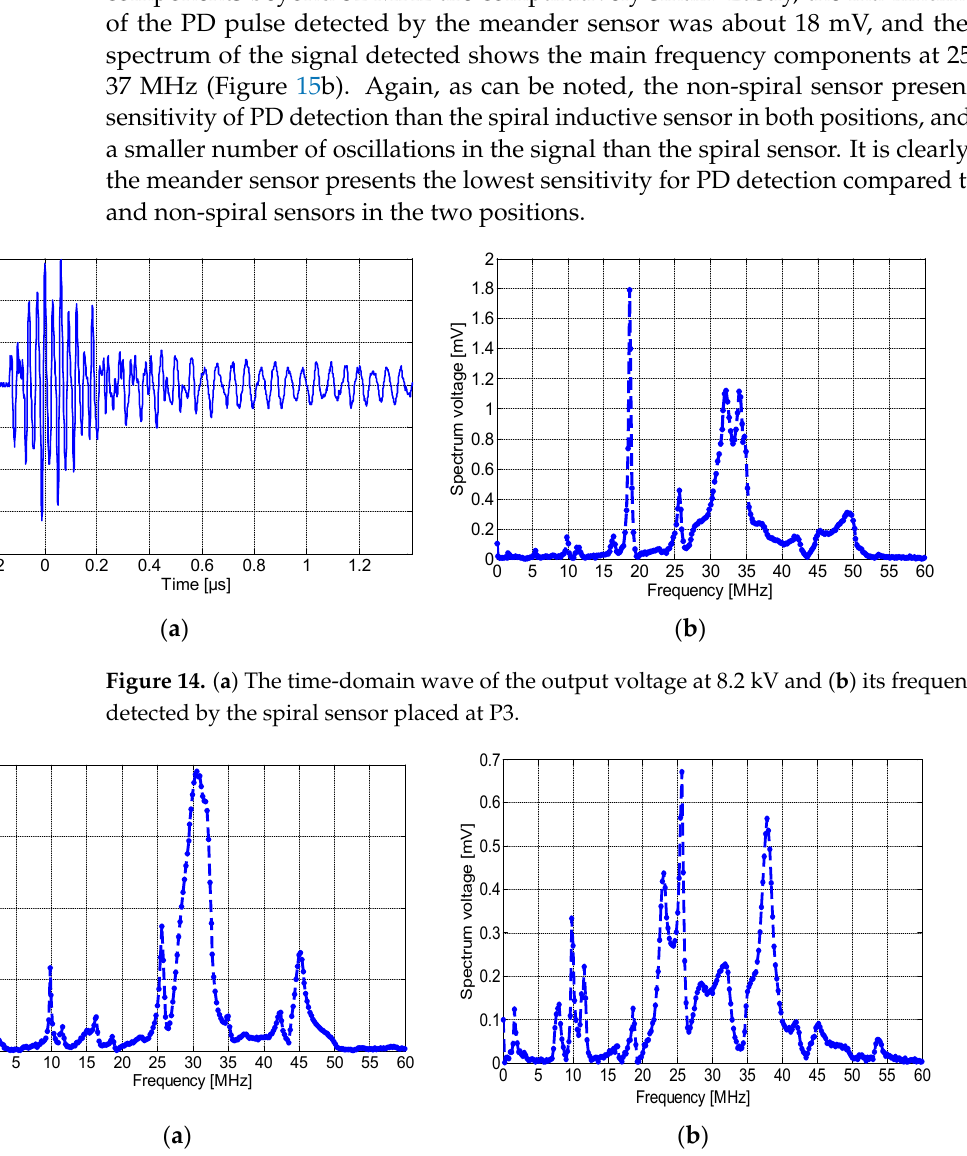
( b ) Figure 16. ( a ) The time-domain wave of the output voltage at 8.2 kV and ( b ) frequency spectrum of the HFCT sensor. 4.2. Notes and Observations Through DPs monitoring, the dielectric condition of high-voltage equipment can be assessed, and insulation defects can be detected and located. HFCT sensors detect the presence of partial discharges, arcs, or sparks by detecting high-frequency pulses flowing in the ground wire [28]. Their basic principle is to produce an induced voltage propor- tional to the fast transient current created by the PD occurrence. Nevertheless, HFCT sensors cannot accurately locate the damaged part of an insulated system. On the other hand, the UHF method could be used for online PD monitoring and can help localize the defects [23]. Indeed, it is through the relationship between the arrival time and/or am- plitude and/or frequency of the output wave from the UHF antenna and the separation distance that the PD can be located (typically three sensors are needed). Since EM waves in space consist of an electric field measured in V/m and a magnetic field measured in A/m, by using an inductive loop, the magnetic field perpendicular to the electric field can be detected [24]. Inductive loops are based on Faraday’s law of induction to measure changes in the magnetic field caused by the PD propagated in the air surrounding the